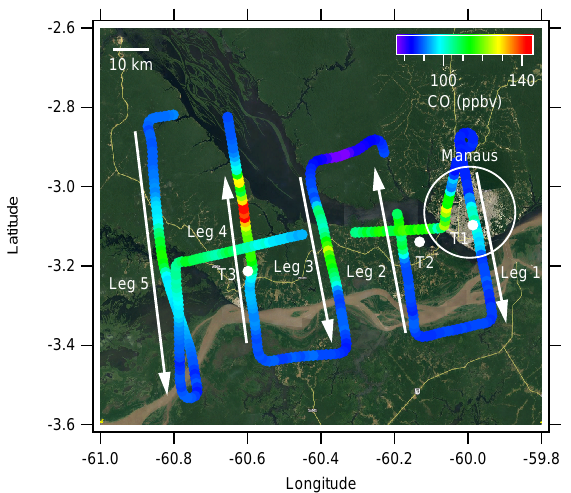
Figure 1. Flight path for the 13 March 2014 flight colored by the CO concentration in units of ppm. Arrows indicate the direction of the flight. The first pass through the pattern was conducted at 500m and then repeated at 1000m. The G-1 took off at 10:12LT and landed at 13:21LT for a total flight duration of 3h and 9min. The white dots show the location of ground measurement sites. The underlying image is from Google